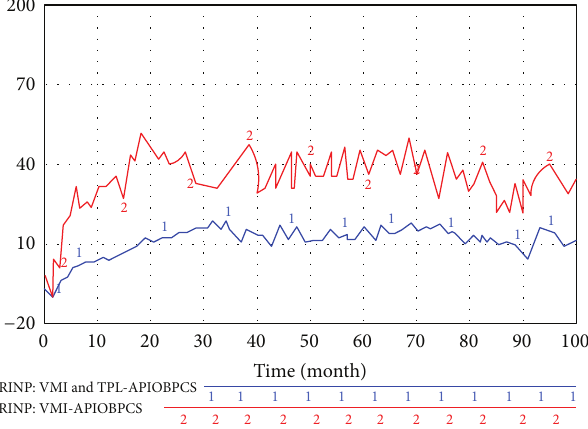
Figure 23: Fluctuation diagram of suppliers’ inventory